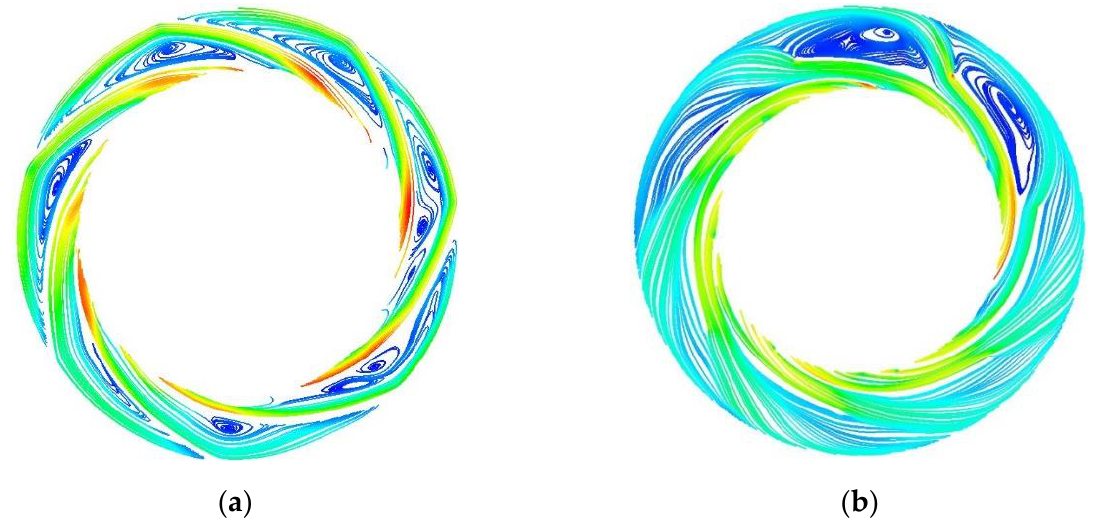
Figure 14. Streamline distribution before and after the guide vane structure improvement. ( a ) Original structure; ( b ) improved structure.